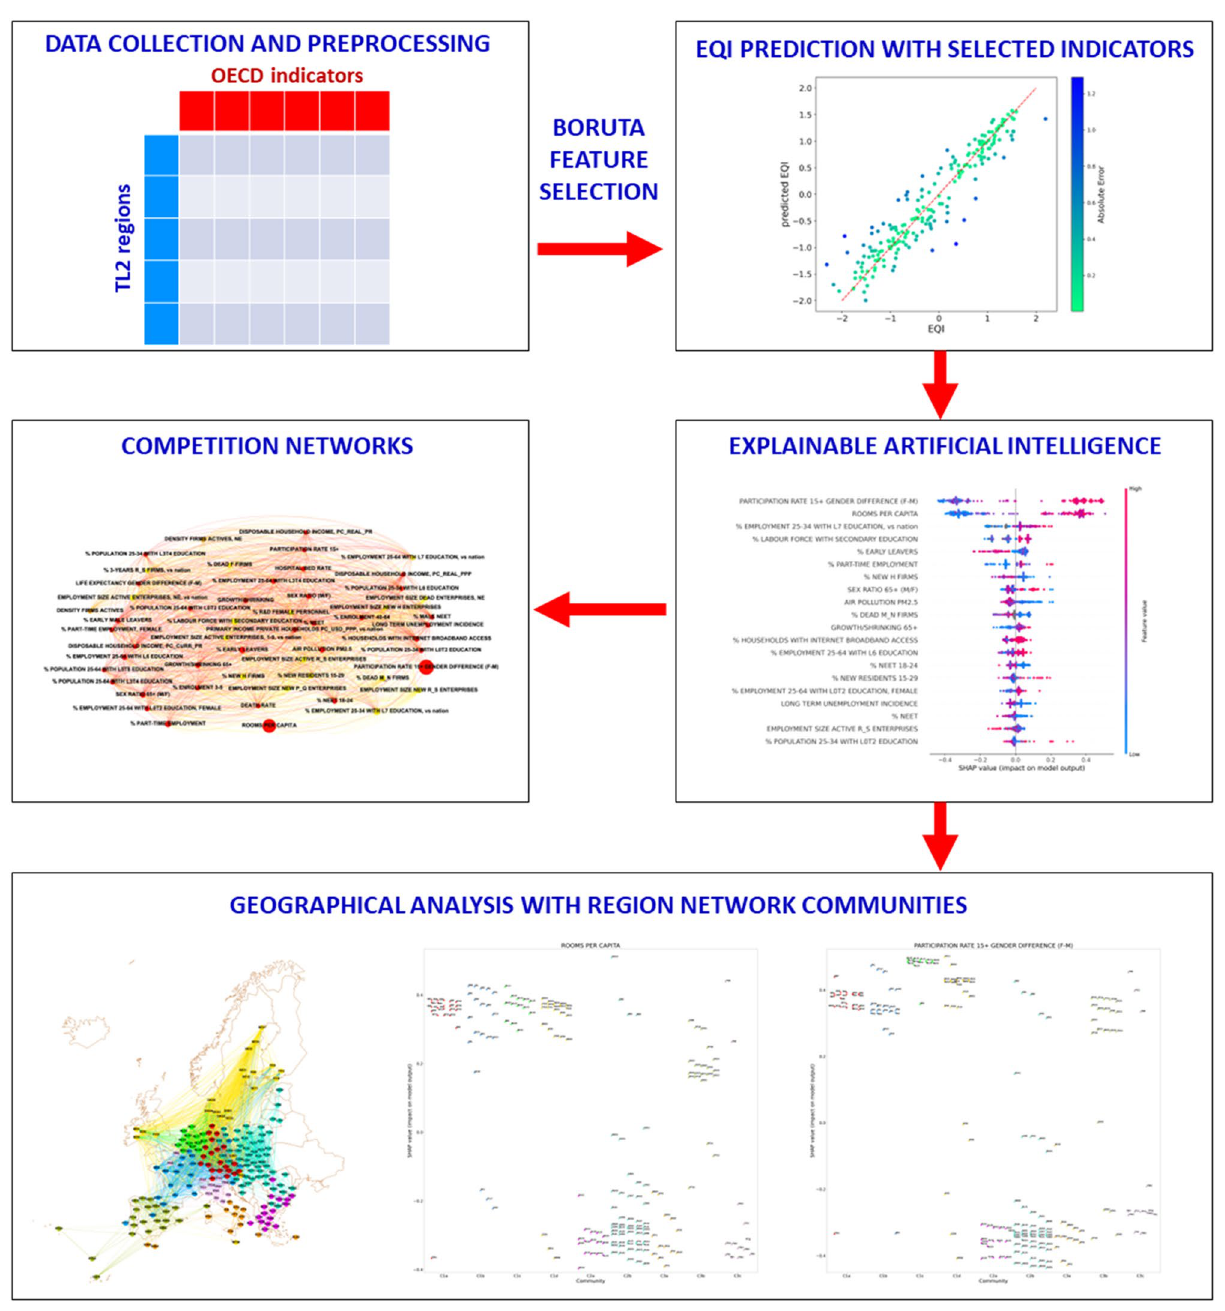
Figure 1. Scheme representing the workflow of the analysis, aimed at measuring the impact of territorial and societal development variables on the perceived government quality expressed by the European Quality of Government Index (EQI). The steps composing the analysis and the related findings are described in detail in the “Results” and “Materials and methods”